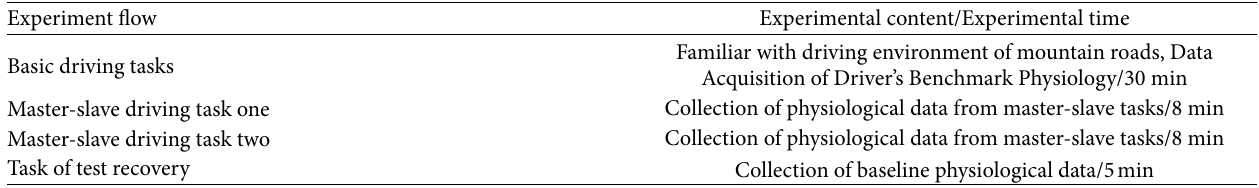
Table 1: Driving simulator experiment and master-slave driving task design.